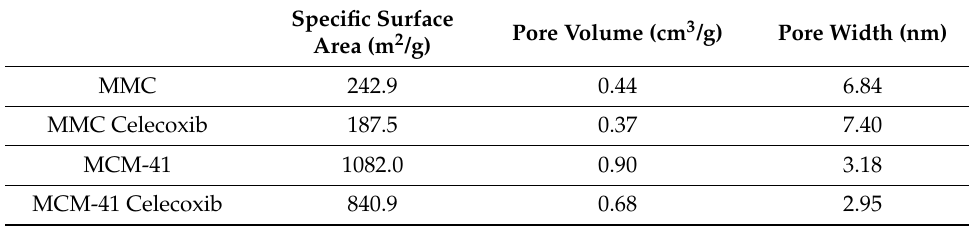
Figure 1. Nitrogen gas sorption isotherms for unloaded and drug-loaded MMC and MCM-41. Table 2. SSA, pore volume, and pore width for unloaded and drug-loaded MMC and MCM-41.